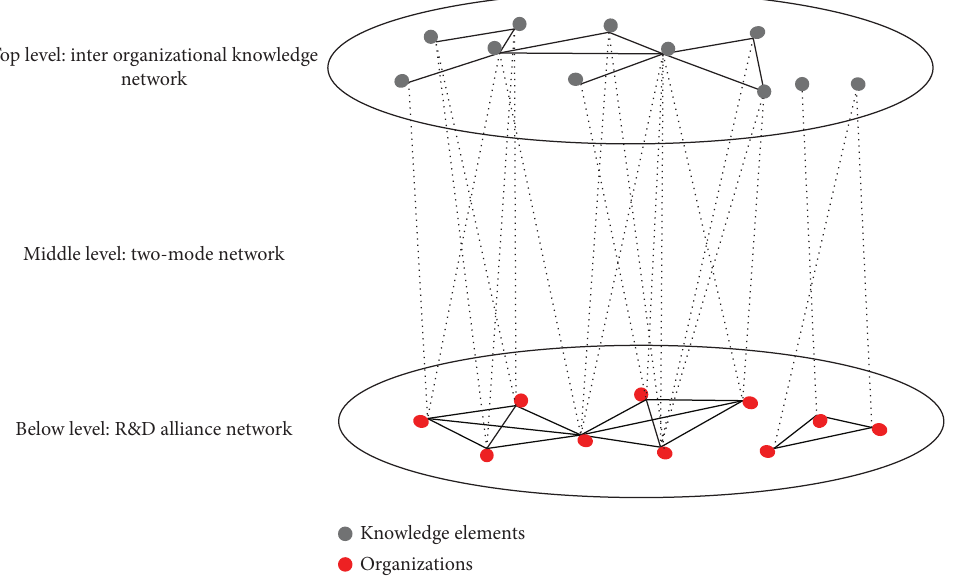
Figure 2: Overview of the theoretical framework of the multilevel